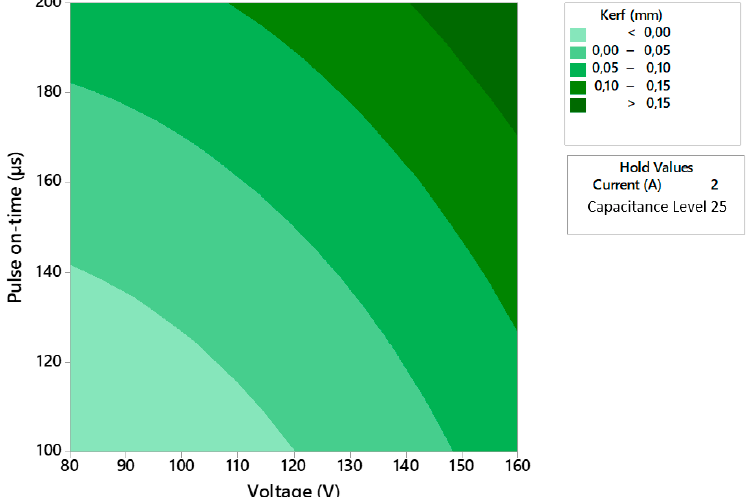
Figure 14. Contour diagram that relates the taper defect to the two main machining